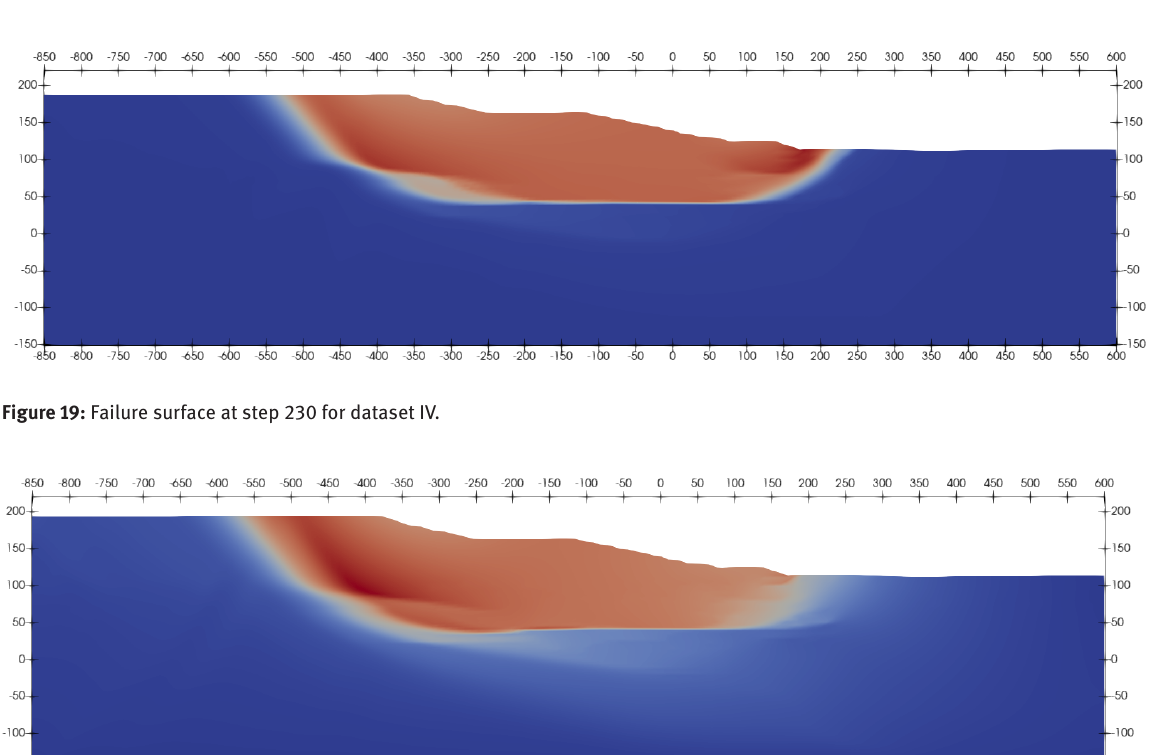
Figure 18: Failure surface at step 210 for dataset IV.